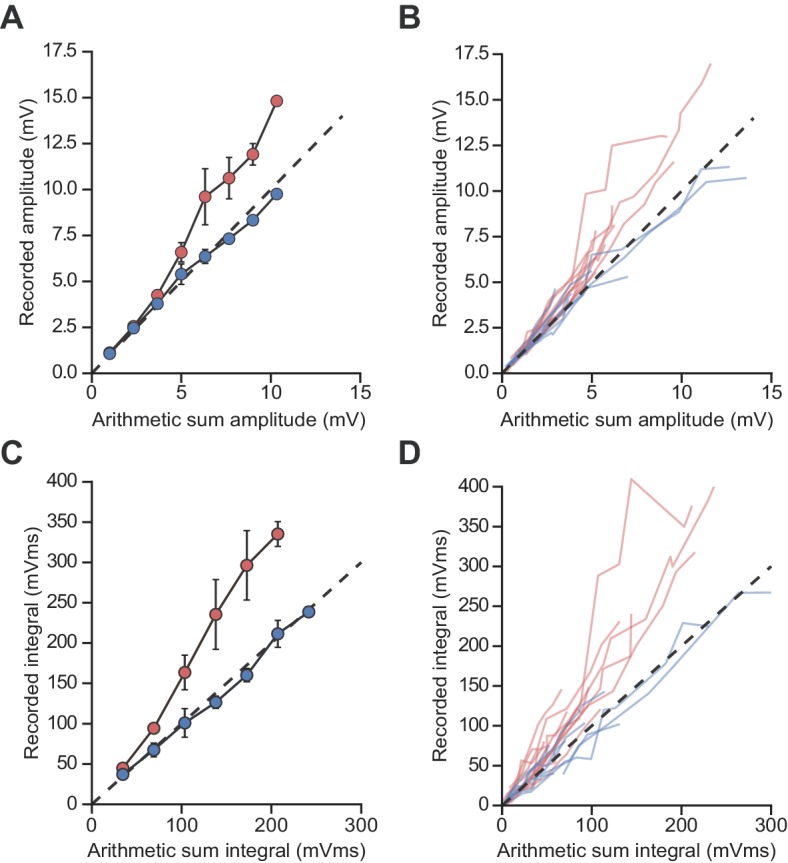
Unscaled uEPSP integration location-dependent nonlinearity.Comparisons of the arithmetic sum of individual uEPSPs and corresponding recorded uEPSPs evoked at locations in stratum radiatum (blue, n = 9) and stratum oriens (red, n = 14). (A, B) Unscaled uEPSP amplitudes, average (A) and raw data (B). (C, D) Unscaled uEPSP integrals, average (C) and raw data (D). For panels (A) and (C) linearly interpolated averages are shown ± SEM.